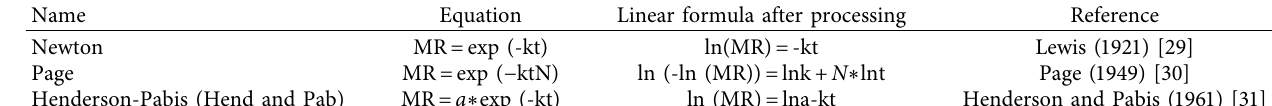
Table 2: Definition of the drying empirical equations used in this article.